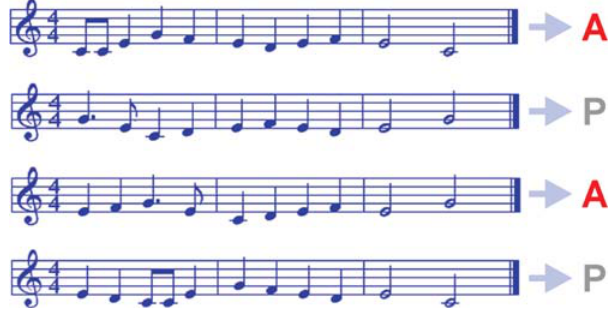
Figure 1. Active/passive melody learning task. Subjects learned to play two unknown melodies on a piano (actively learned melodies, marked ‘A’) and were passively familiarized with two other melodies (passively learned melodies, marked ‘P’). The assignment to the two learning conditions was balanced across subjects.